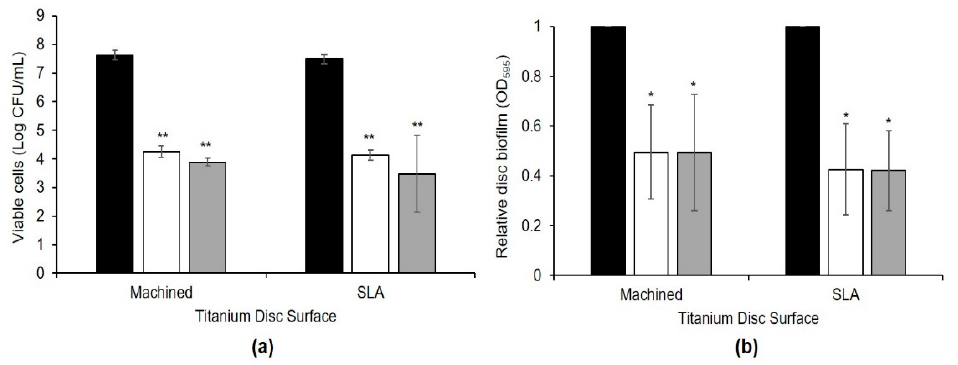
Figure 4. Inhibitory effects of W. cibaria CMU and CMS1 on multi-species implant biofilm formation measured using ( a ) viable cell counting and ( b ) relative biofilm amount. Titanium discs with machined or sandblasted with large grit and acid etching (SLA) surface were used. ( a ) Number of viable cells in the biofilm formed on the discs for 3 d; ( b ) stained biofilm formed for 3 d using crystal violet and measured at OD 595 . Black bar, control; white bar, W. cibaria CMU-treated; grey bar, W. cibaria CMS1-treated. Significant differences as compared to control determined as * p < 0.05, ** p ≤